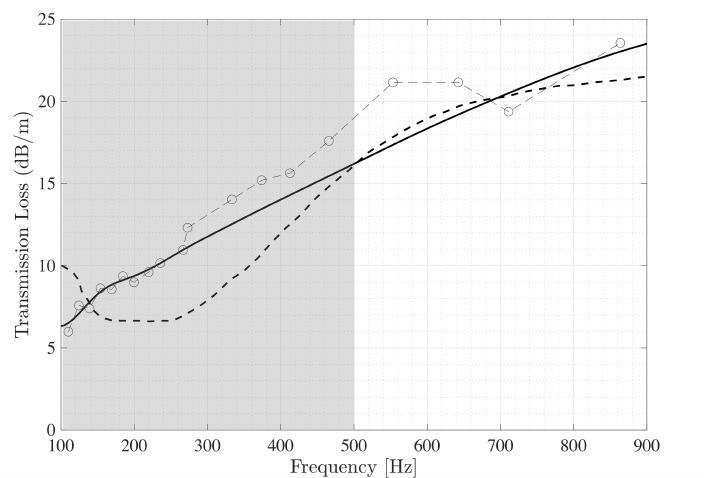
Figure 7. Comparison of the transmission loss between the modeling results (the black solid line) and the data from the measurement [42] (the line with circles) and the numerical air bubble curtain model [27] without the assumption of the bubble size distribution coefficients (the black dashed line). The light gray area indicates the frequencies of interest in offshore pile driving (<500